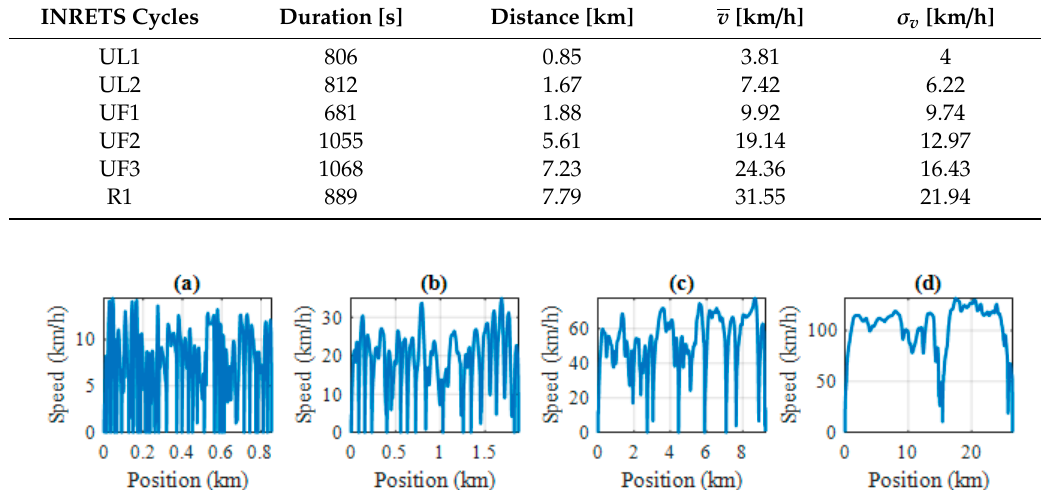
Table 2. Characteristics of the UL1, UF1, R2 and A2 INRETS driving cycles.